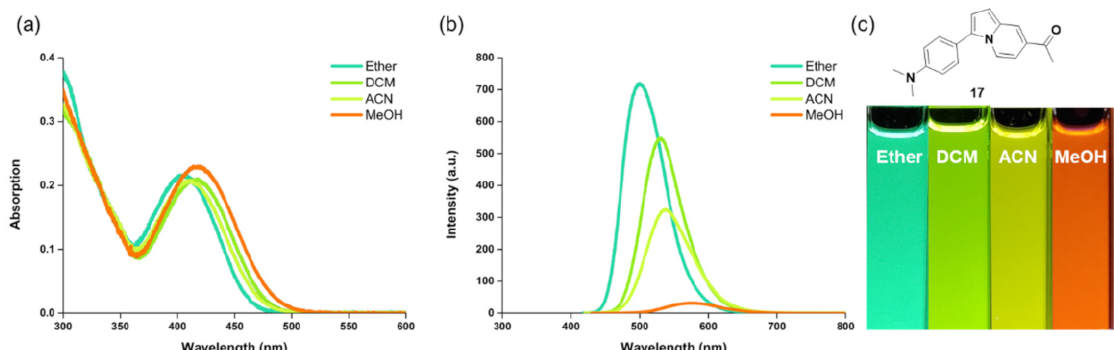
Figure 3. Solvatochromism of compound 17 . ( a ) Absorbance and ( b ) emission spectra of compound 17 in solvents with different polarity (diethyl ether, DCM, ACN, or MeOH). ( c ) Fluorescence photo image of compound 17 in different solvents taken under 365 nm UV light